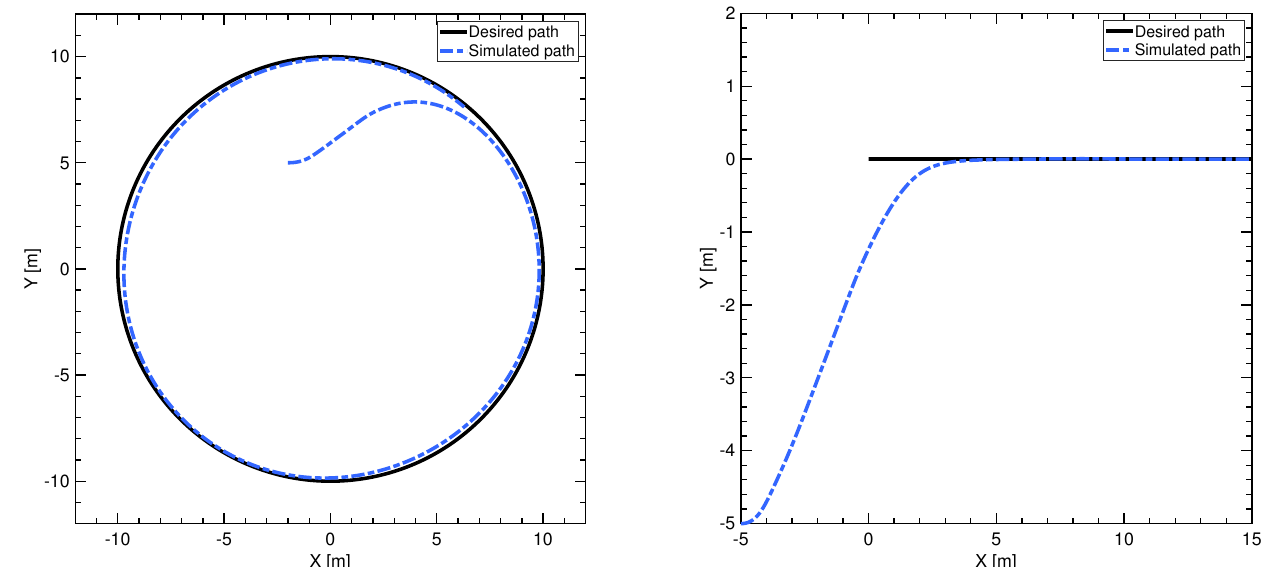
Figure 20. Trajectory following test in case of incorrect knowledge of resistance coefficients: circular ( left ) and straight paths ( right ).